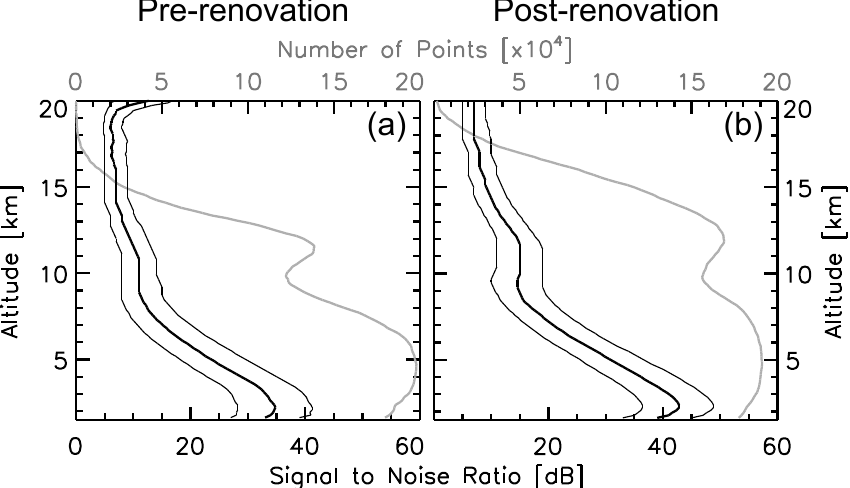
Figure 11. Average SNR (black curves) and the number of reliable (6 ◦ zenith angle) complementary beam pairs of measurements (grey curves), before and after renovation (panels a and b, respectively). The thin black lines correspond to the upper and lower quartile of the SNR distribution. SNR values shown here are peak signal power spectral density to noise. A whole year of measurements has been used for each figure (2010 and 2012,